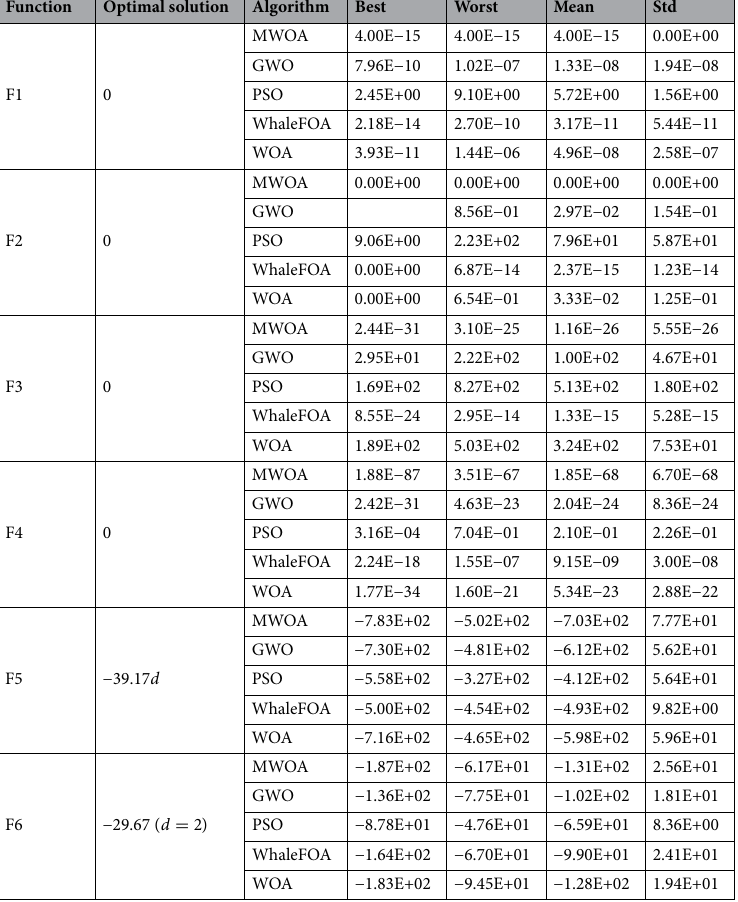
Table 1. Benchmark function